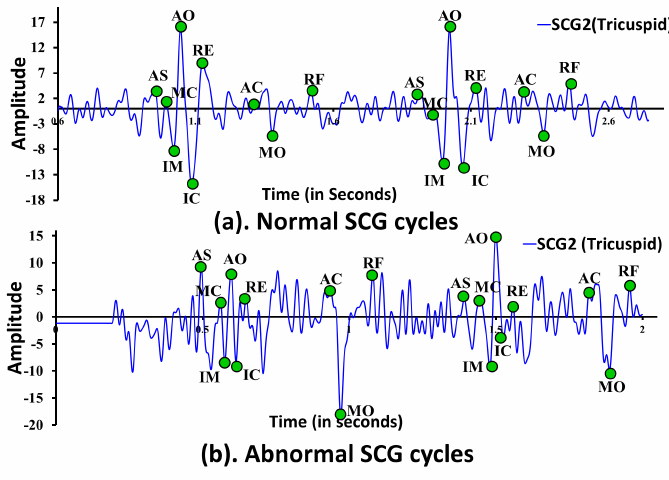
Figure 5. Feature points delineation in ( a ) normal SCG cycles; ( b ) abnormal SCG